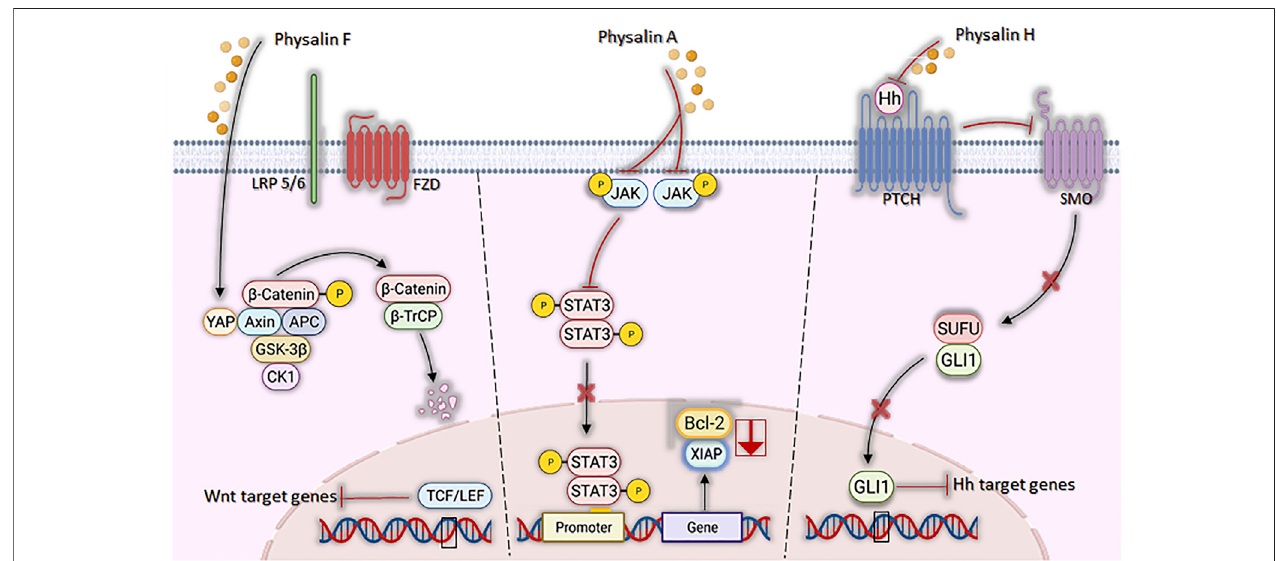
FIGURE5| MechanismsofactionofphysalinsA,F,andHinaberrant signalingpathways. PhysalinFinhibitsWnt/ β -catenin signaling,acceleratingthedegradation of β -catenin and promoting the binding of YAP to the Axin, APC, CK1 and GSK-3 β destruction complex. β -catenin phosphorylation facilitates its recognition by β -TrCP, leadingtoitsdegradationbytheubiquitin-dependentproteasomepathway.PhysalinAinhibitsthephosphorylationoftheJAKreceptorandtheSTAT3protein,inhibiting theirtranslocation tothe nucleus and downstreamBcl-2 and XIAP transcription. Physalin Hinhibits the Hedgehog pathway by suppressing Hh protein expression, impeding its binding to Hh-related proteins (PTCH) and inhibiting smoothened (SMO), which in turn allows the SUFU-containing GLI processing complex to generate transcriptional repressors, disrupting binding of GLI1 to its DNA binding domain and the non-expression of PTCH and Bcl-2.